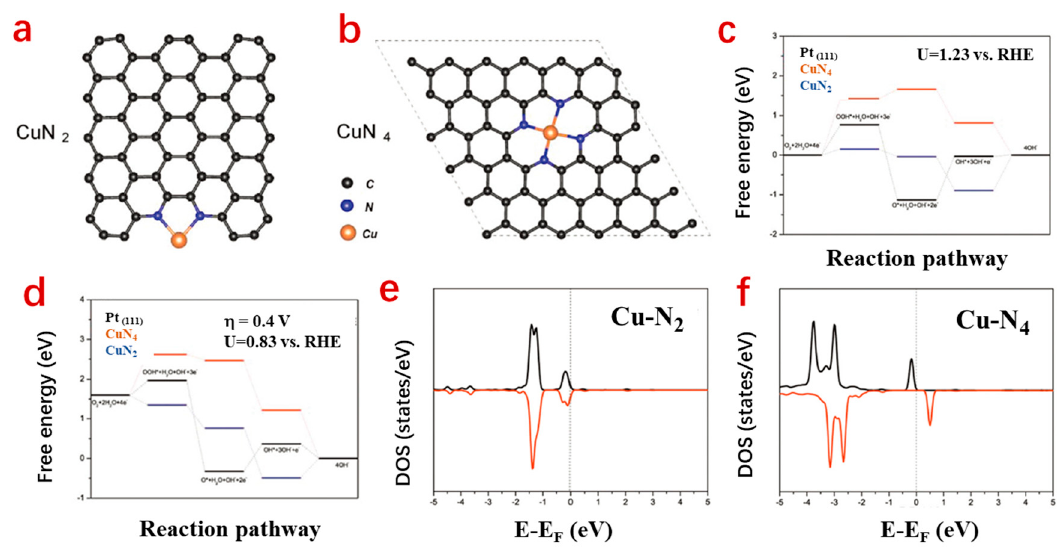
Figure 8. Optimized structures of Cu–N 2 ( a ) and Cu–N 4 ( b ); ORR free energy diagrams of CuN 2 and CuN 4 ( c , d ) at different potentials; local density of states (LDOS) of the d-orbitals of Cu atoms in Cu–N 2 ( e ) and Cu–N 4 ( f ) [54].